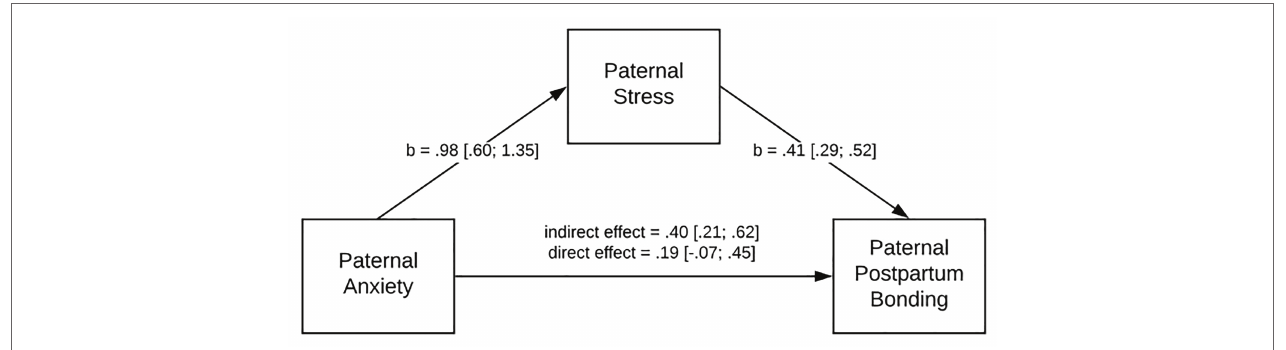
FIGURE 1 | Mediating model of paternal anxiety on paternal postpartum bonding via paternal stress.